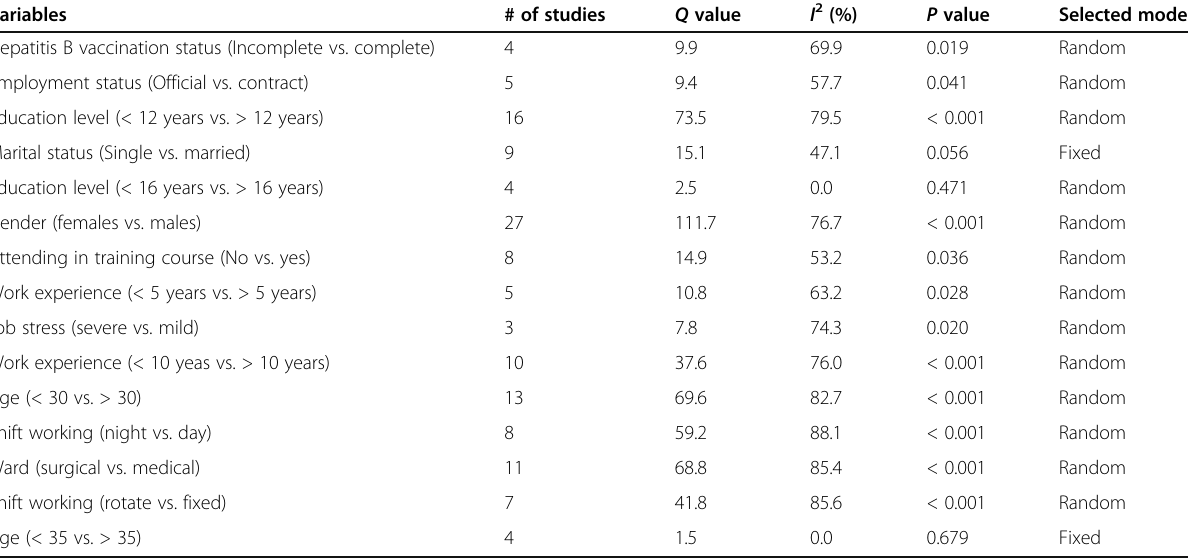
Table 2 Results of heterogeneity among included studies Variables Hepatitis B vaccination status (Incomplete vs.